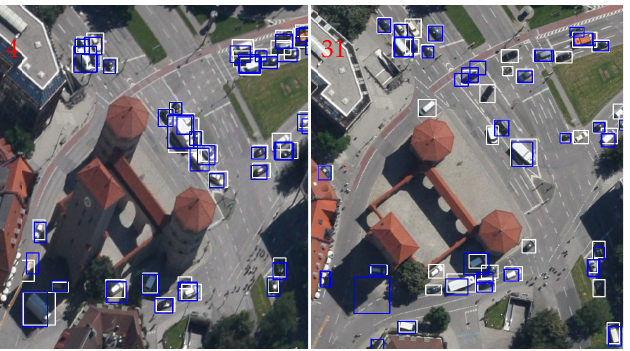
Figure 18. Tracking results by AerialMPTNet on the frames 4 and 31 of the “MunichCrossroad02” sequence of the KIT AIS vehicle dataset. The predictions and ground truth bounding boxes are depicted in blue and white, respectively. Several hindrances such as changing viewing angle, shadows, and occlusions (e.g., by trees) are